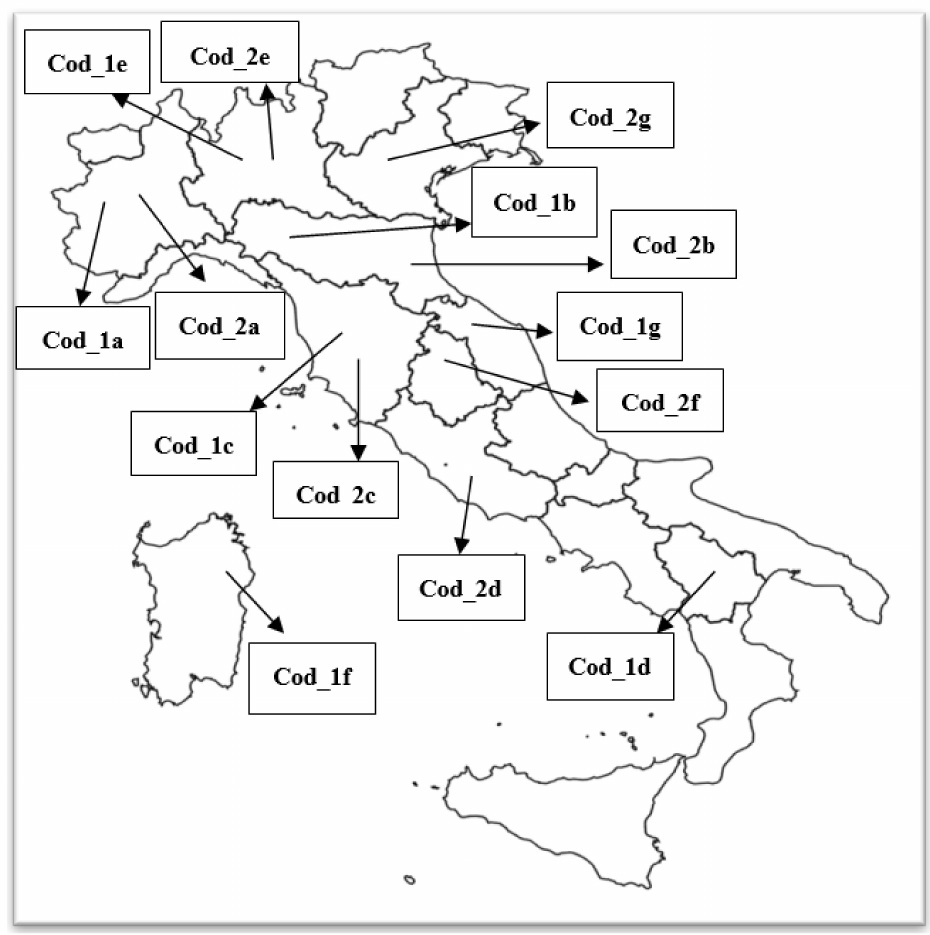
Figure 1. Location of the farms from which the different field population of Dermanyssus gallinae tested were